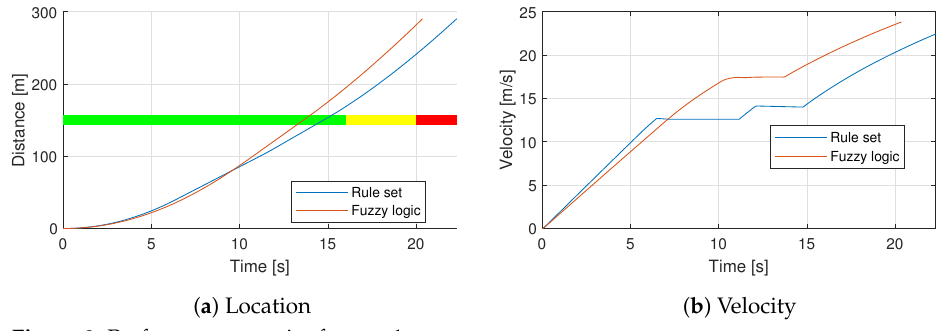
Figure 8. Performance metrics for test 1.